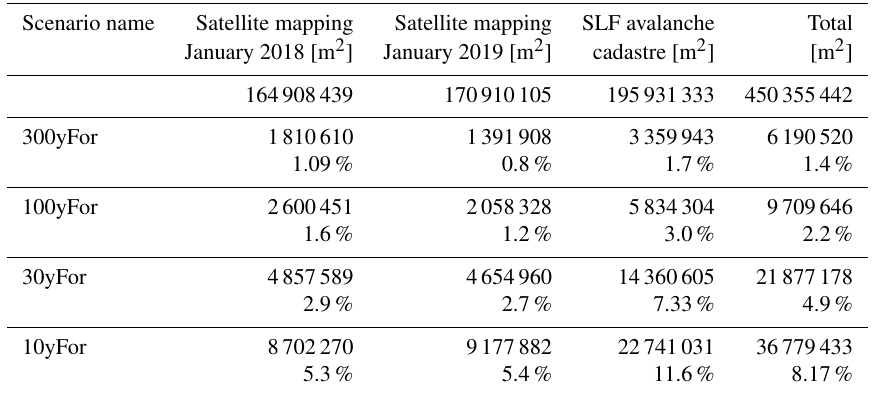
Table 3. Avalanche-affected area in the reference datasets (SLF database and satellite mapping) within the canton of Grisons which is not affected in the simulation results in comparison to the total affected area (%). An example for visualization of a subset of regions is given in Fig.